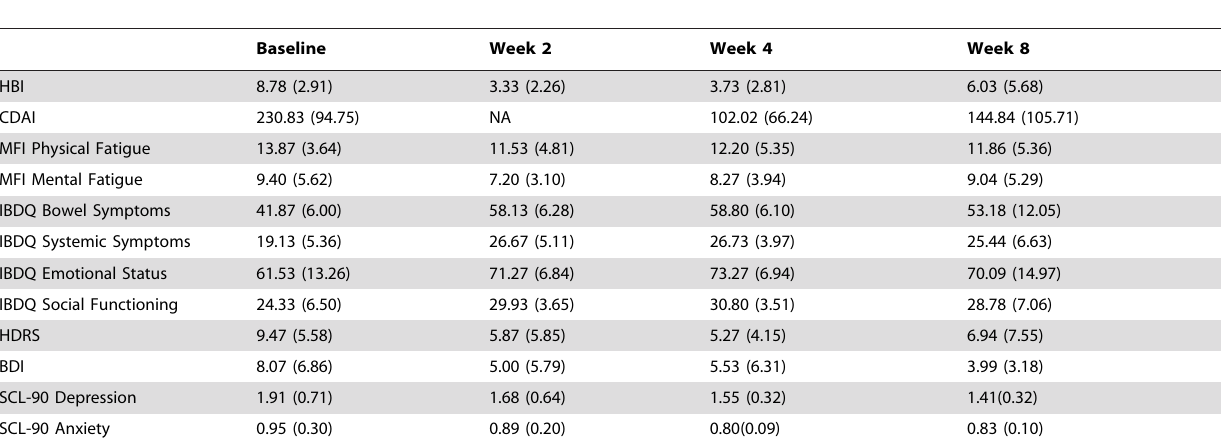
Table 1. Total scores of disease activity and psychopathological and behavioural assessments at each time point.